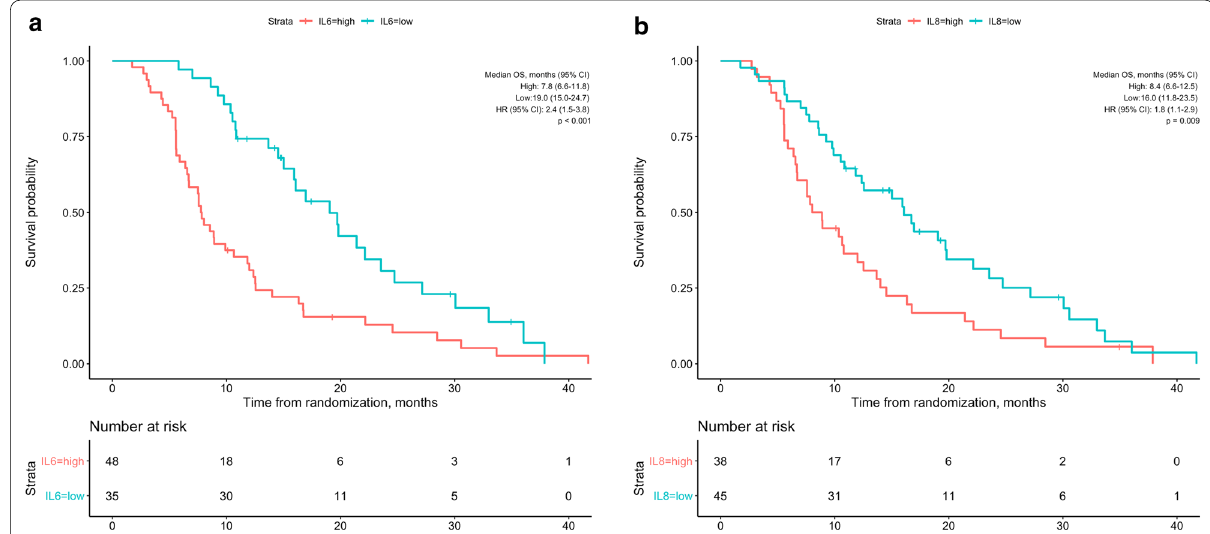
Fig. 2 Kaplan–Meier curves showing overall survival of patients grouped by high and low baseline IL6 ( a ) and IL8 ( b ) values. P values were calculated using the log rank test